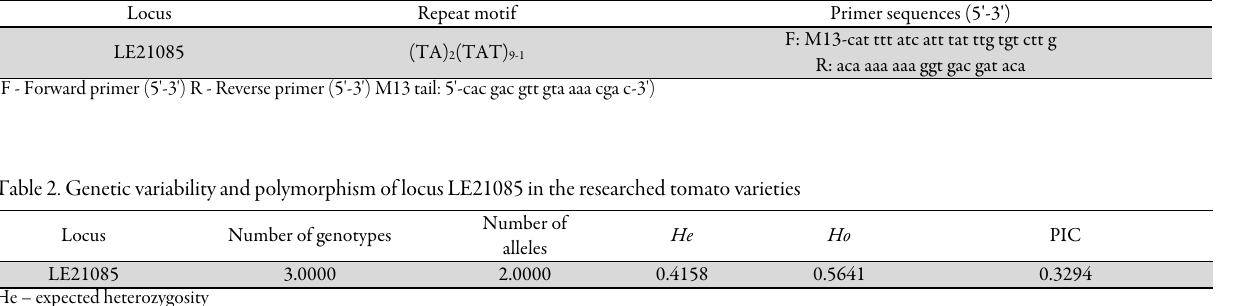
Table 1. General data for microsatellite locus LE21085 and primers used in this study Locus